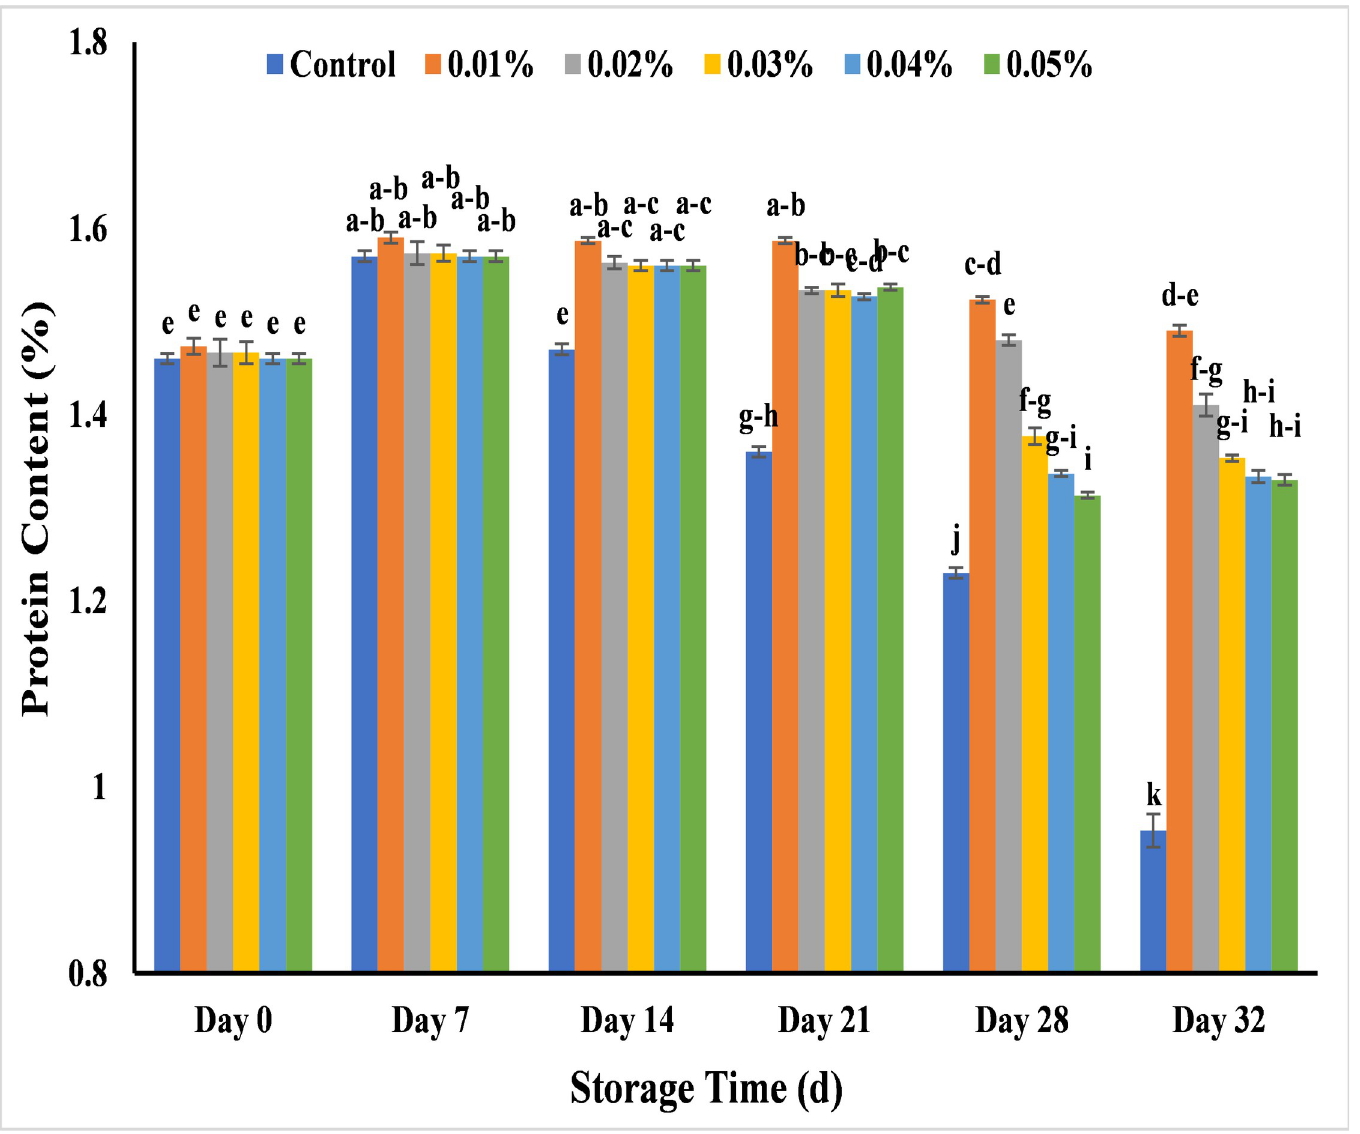
Fig 21. Effect of various AgNPs concentration (T0 = control, T1 = 0.01%, T2 = 0.02%, T3 = 0.03%, T4 = 0.04%, T5 = 0.05%) on protein content of Cavendish banana (BASRAI) during 32 days of storage.